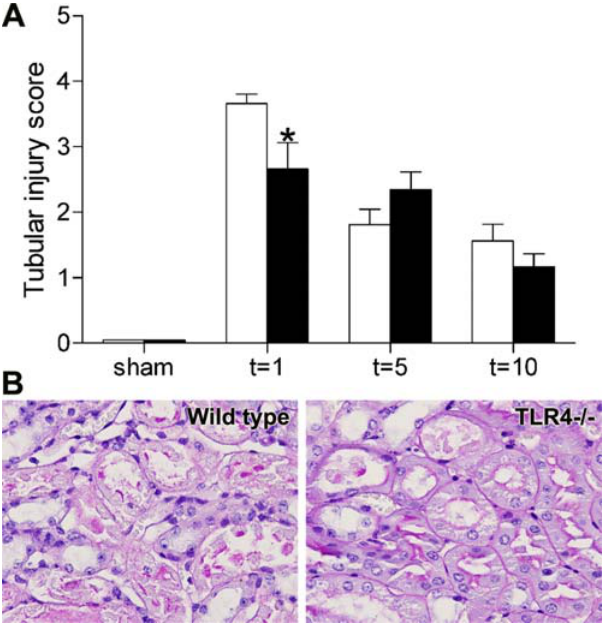
Figure 2. Scoring renal tubular damage of wild type and TLR4 2 / 2 mice. Score for histopathology after renal I/R injury (A) using PAS-D-stained renal tissue sections (B; representative for t=1). Tubular damage was significantly lower in the outer medulla of kidneys of TLR4 2 / 2 mice (black bars) than in kidneys of wild type mice (white bars) one day after I/R injury. Data are mean 6 SEM of 8 mice per group (sham-operated animals: n=3/group). * p , 0.05. doi:10.1371/journal.pone.0003596.g002 similar in the supernatant of TLR4 2 / 2 TECs compared with wild type TECs when subjected to simulated ischemia. The levels of TNF- a were below detection level. These data show that TLR4 on epithelial cells can indeed contribute to the induction of proinflammatory responses upon ischemic injury in vitro .